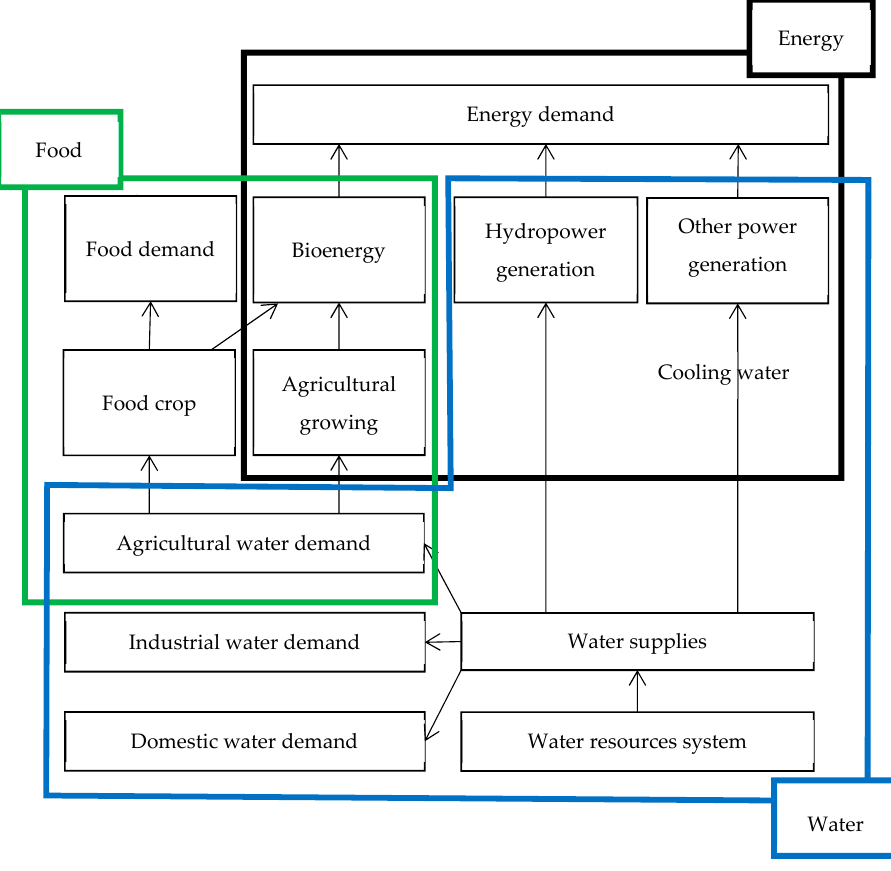
Figure 1. Urban metabolic analysis of food, water, and energy resources systems.